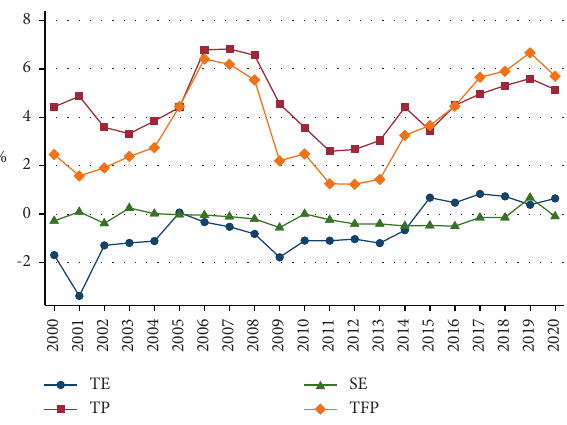
Figure 2: Diagram of provincial TFP growth rate and its decomposition.